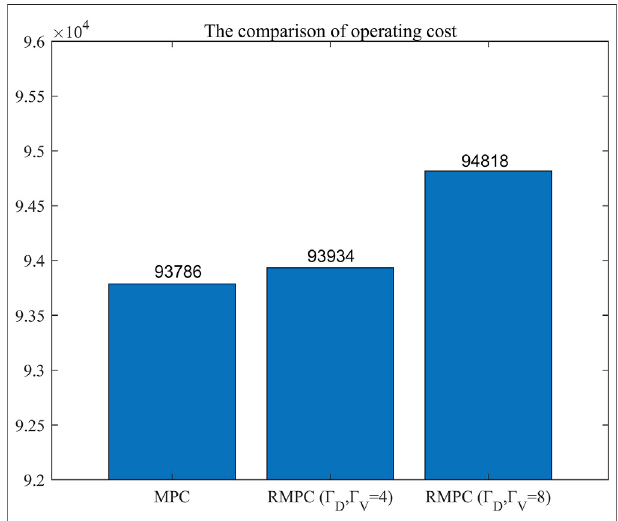
FIGURE 13 | The comparison of operating